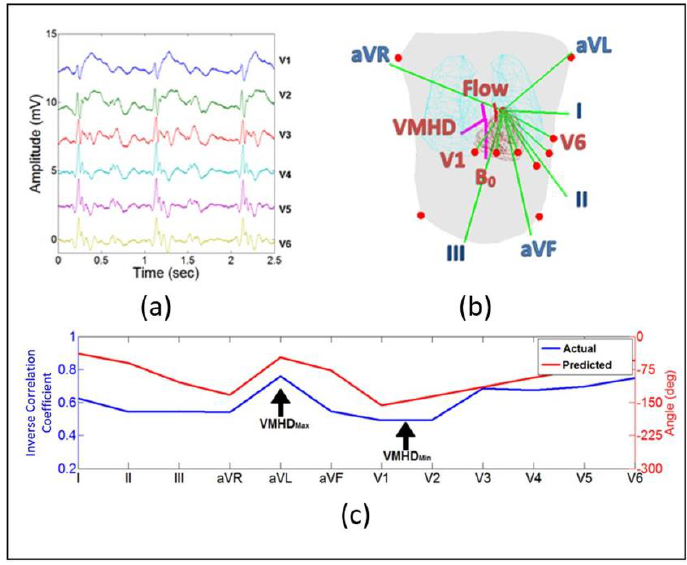
Figure 2. Validation of the thoracic model to predict magnetohyrodynamic voltages (V MHD) . Data are averaged from all subjects. ( a ) Representative ECGs (V1–V6) recorded inside the MRI bore (3T) from the study population used to validate the thoracic model as a predictor for induced V MHD . ( b ) Mapped electrical vectors (green) from 12-lead ECG in the thoracic body model. Vectors used to determine angular displacement between predicted V MHD vector and each lead. ( c ) The angular displacement between each lead and the predicted V MHD vector represents the quantity of V MHD predicted to be present in the lead (red line). The inverse correlation coefficients between ECGs acquired outside and inside the MRI bore represent the quantity of V MHD actually present in each lead (blue line). In the scale used for the inverse correlation coefficients, 0 represents perfect correlation between the two ECG signals and, thus, indicates no V MHD and 1 represents no correlation between the two signals and, thus, indicates maximum V MHD .